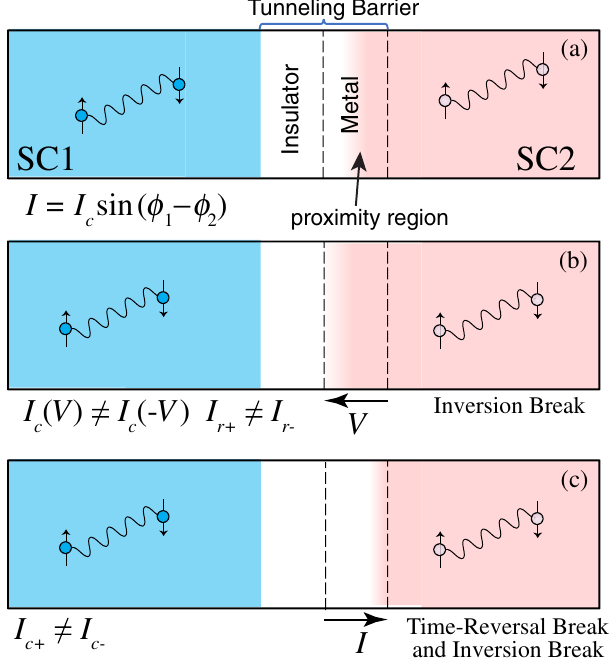
FIG. 2. (a) The geometric setup for a Josephson diode in an extreme limit, which is formed by SC Δ 1 on the left, SC Δ 2 on the right, and the tunneling barrier (TB). The Josephson current is determined by I ¼ I c sin ð ϕ 1 − ϕ 2 Þ , where ϕ 1 = 2 is the phase and I c is the critical current. The tunneling barrier layer in the extreme limit is formed by an insulator layer and a metallic layer ( N ), and the Δ 1 influences the N layer by forming the proximity region. (b) An inversion breaking JD is controlled by voltage with I ð V Þ ≠ I ð − V Þ or I ≠ I c c r þ r − , which effectively adjusts the proximity region. To illustrate this point, the voltage (positive) enlarges the proximity region, which increases the I c . (c) A time- reversal breaking JD (with inversion breaking) controlled by current flow I with I c þ ≠ I c − . To illustrate this point, the current following in the positive direction reduces the proximity region, which decreases the I c